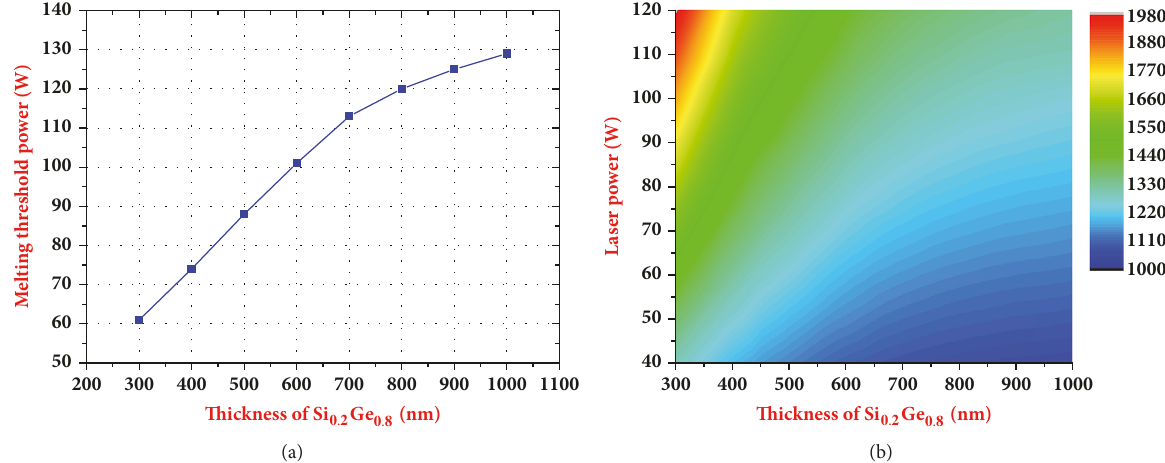
Figure 6: (a) Melting threshold power as a function of Si 0.2 Ge 0.8 thicknesses at 873K. (b) Peak temperature at the surface of Si 0.2 Ge 0.8 layer simulated using a range of laser powers and Si 0.2 Ge 0.8